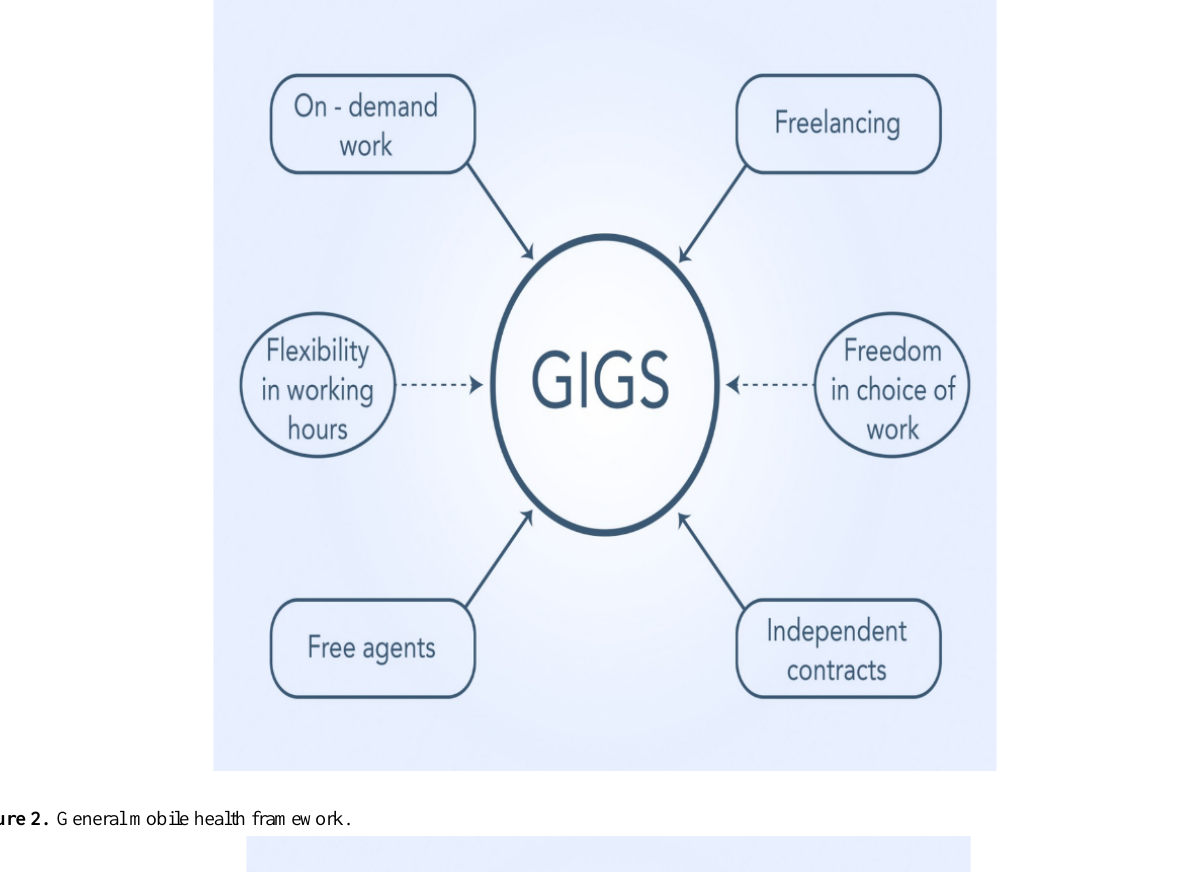
Figure 1. Gig economy structure.